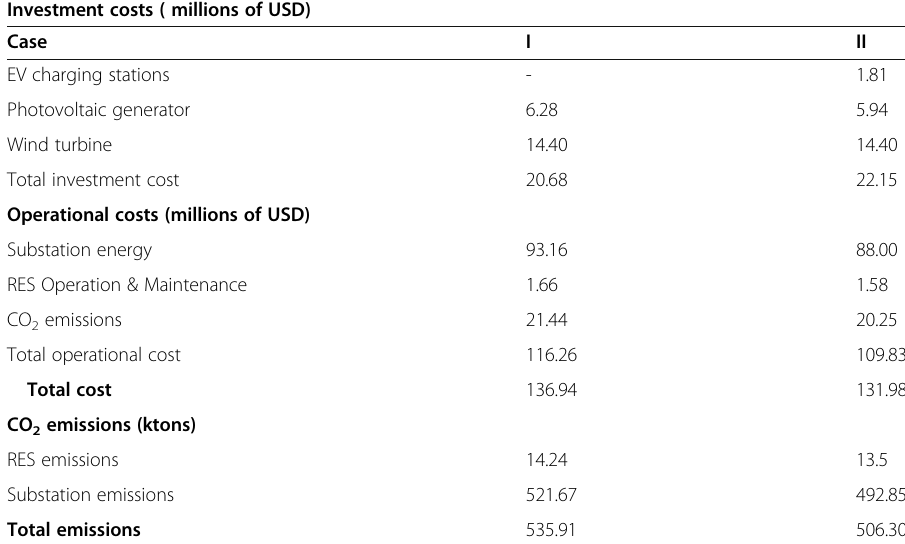
Table 3 Main results for Cases I and